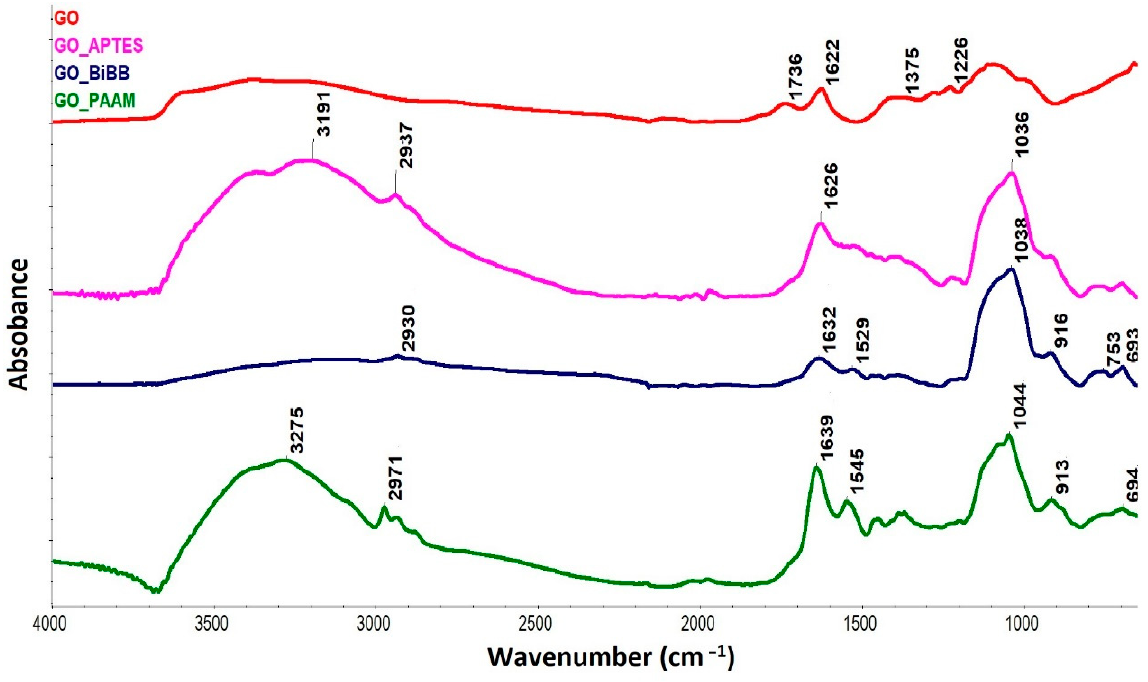
Figure 2. Normalized FTIR spectra of the pristine GO sheets and after subsequent modification with APTES (GO_APTES) and BIBB (GO_BIBB) and SI-ATRP of acrylamide (GO_PAAM).